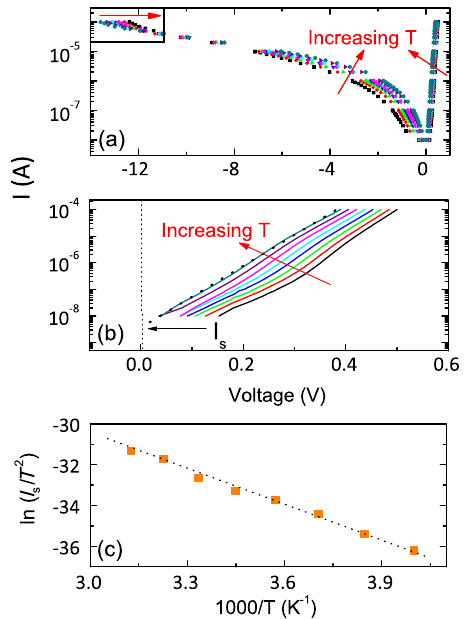
FIG. 6. (a) Plot of the temperature dependence of the current ( I ) vs voltage ( V ) curves measured across a graphene/GaAs junction from 250 K up to 320 K with 10 K intervals separating each isotherm. The arrows indicate the direction of increasing temperature. (b) Plot of the temperature dependence of I - V curves taken on graphene/GaAs junctions at different tempera- values from Fig. 6(b) are plotted in terms tures. (c) Extracted I s =T 2 vs 1000 =T . of ln I s